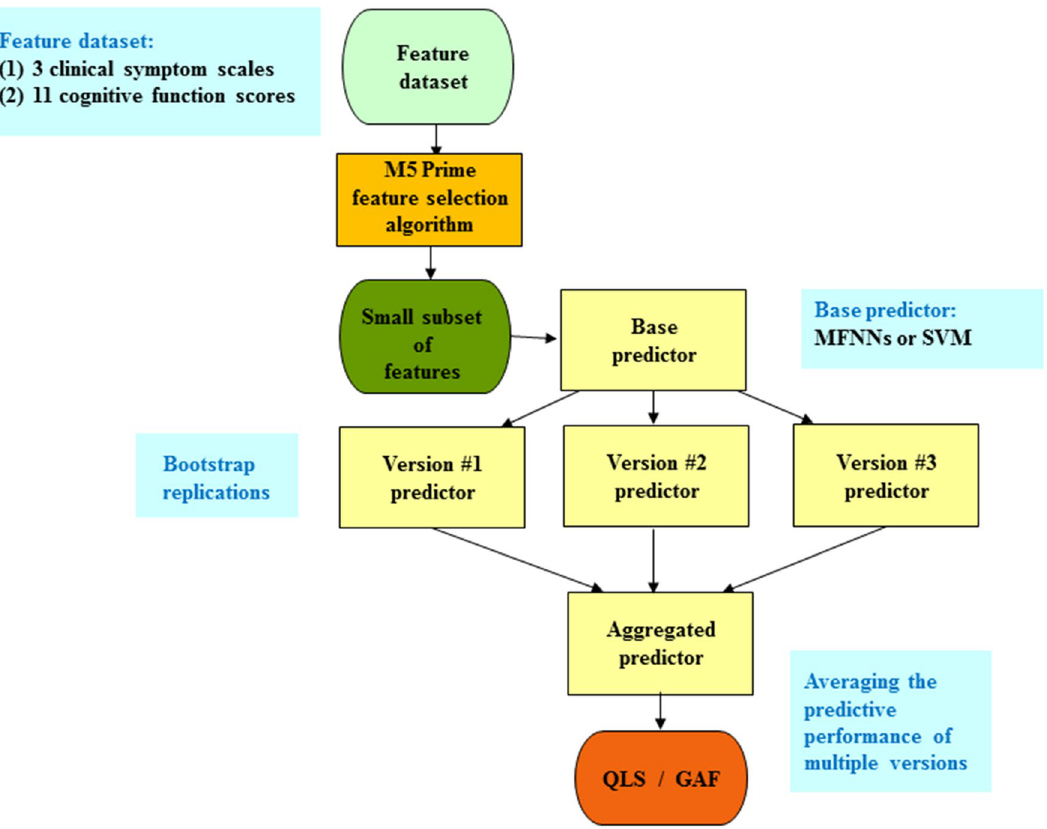
Figure 1. The schematic illustration of the bagging ensemble predictive algorithm with feature selection. First, the M5 Prime feature selection algorithm is performed to select a subset of features, which serves as the input to the bagging ensemble predictive algorithm. The idea of the bagging ensemble predictive algorithm is to generate the multiple versions of a base predictor by bootstrap replications. The final prediction is then produced by averaging the predictive performance of the multiple versions. The base predictor was chosen as multi- layer feedforward neural networks (MFNNs) or support vector machine (SVM) in this study. GAF = Global Assessment of Functioning; QLS = Quality of Life